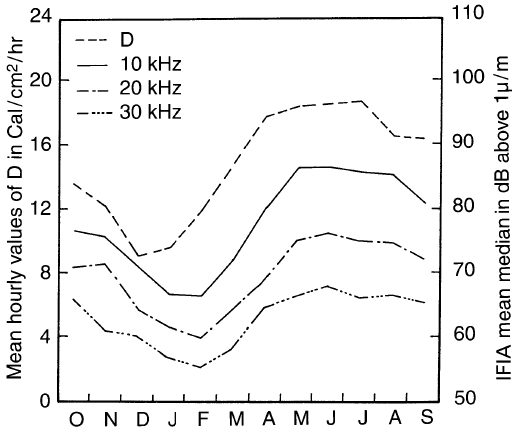
Fig. 5. Mean hourly values of diffuse radiation and median IFIA plotted month by month